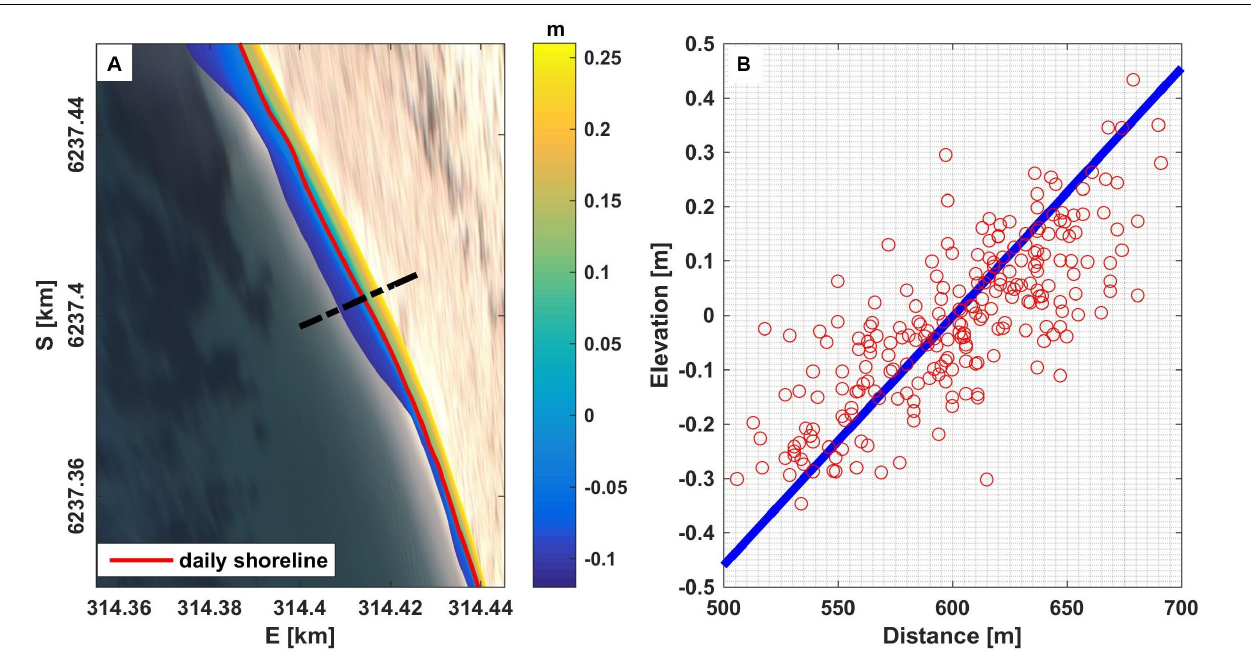
FIGURE 3 | (A) Daily intertidal bathymetry on 16 November 2015, the red line represents the shoreline at 0 m and the dashed black line is the location cross-section profile at (B) . (B) A modeled cross-section profile at S 6237.4 km in November 2015 (blue line), red dots are the corresponding shoreline positions recorded during the